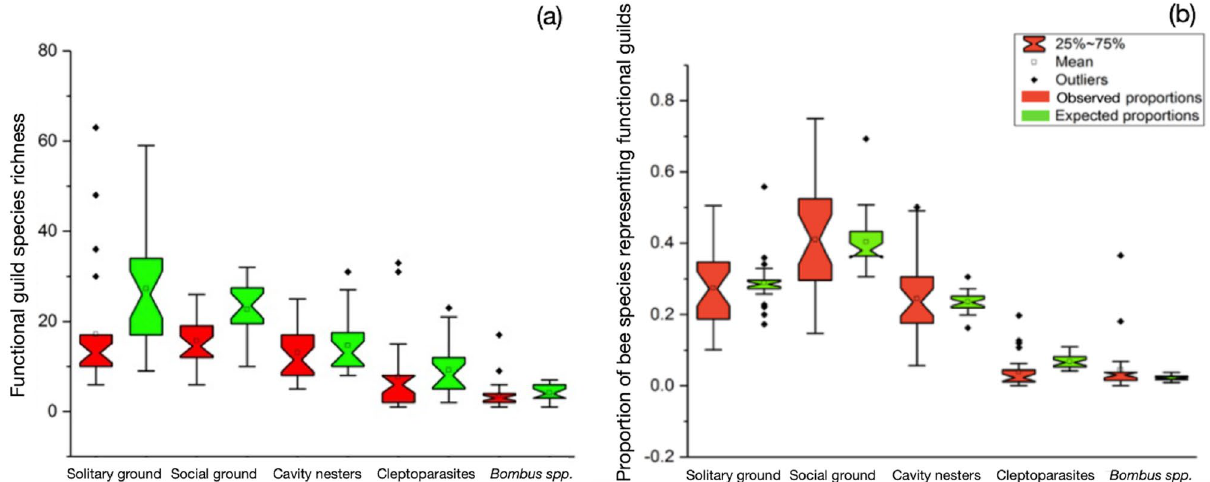
Figure 5. Notched-box plots depicting differences between observed and expected (maximum) ( a ) species richness and ( b ) proportion of bee species representing each functional guild: solitary ground nesters; social ground nesters; cavity nesters; cleptoparasites; and bumblebees ( Bombus spp.). Alignment of notches denotes no significant difference between observed and expected species richness and proportional abundance for each functional